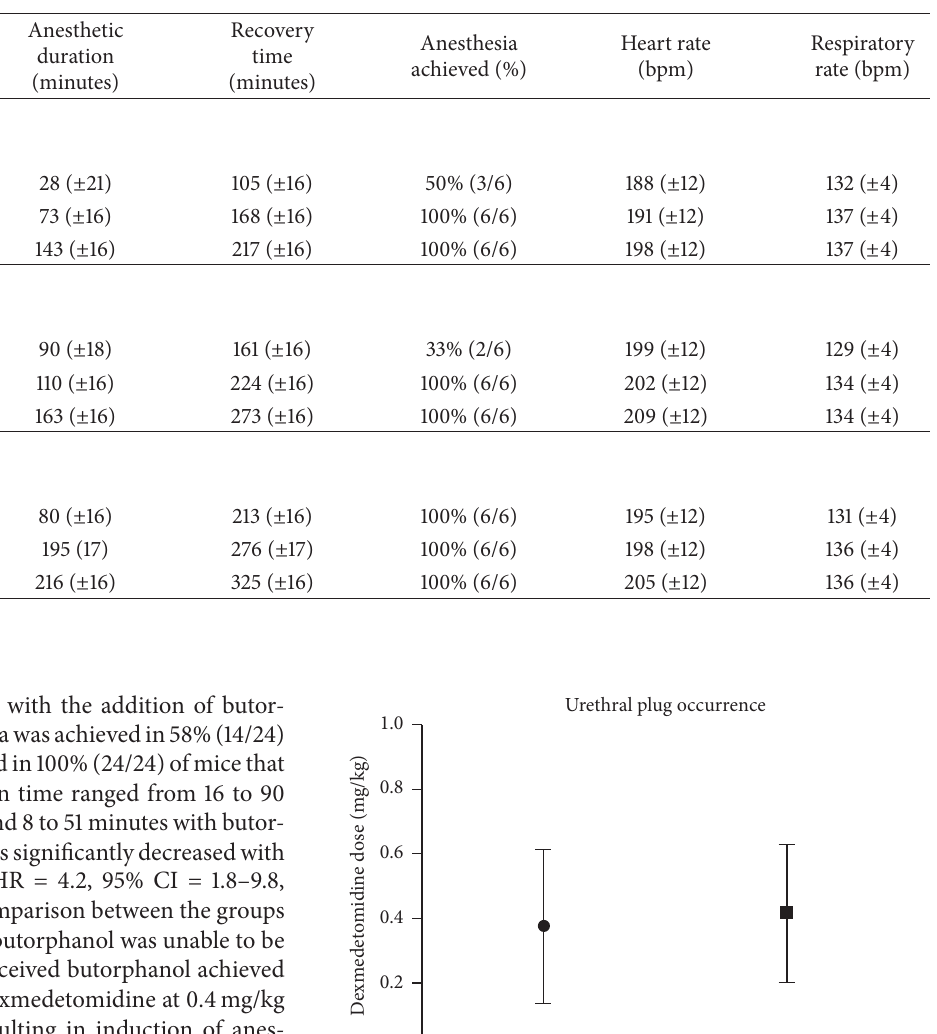
Table 3: Trials with dexmedetomidine, tiletamine-zolazepam, and butorphanol (DTZB). Dexmedetomidine and tiletamine-zolazepam were administered IP and butorphanol was administered at 3 mg/kg SC. Data is reported in marginal means and standard error.